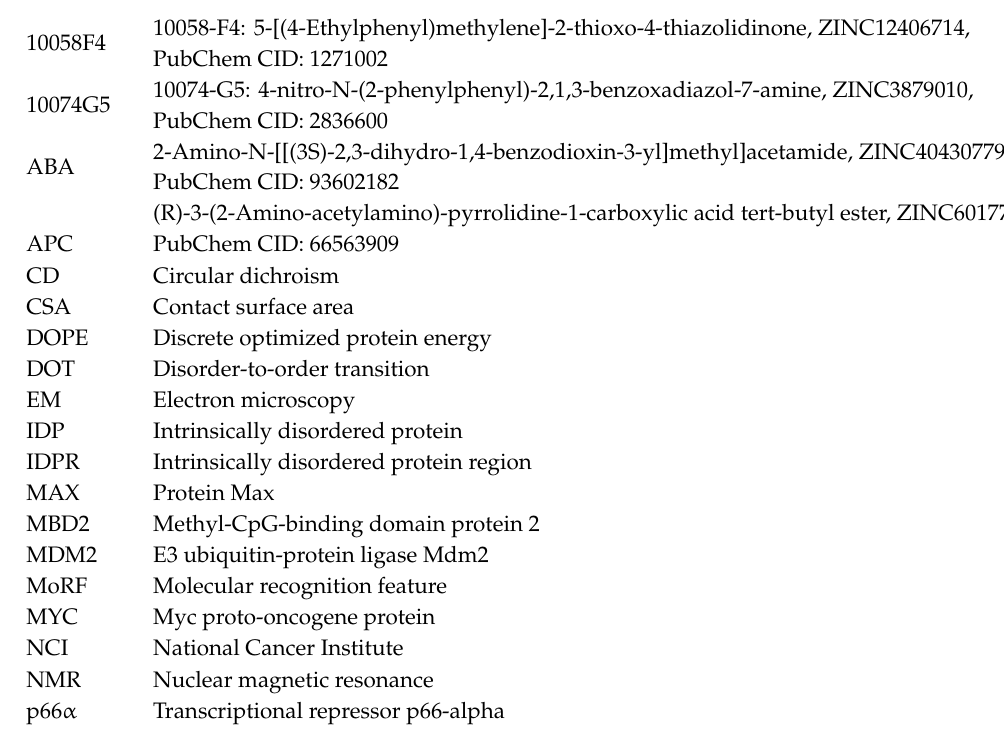
p66 α binding region peptide docking result contact mapping, Figure S6. APC-focused docking score comparison p66 α , 5 peptides) without APC (wo